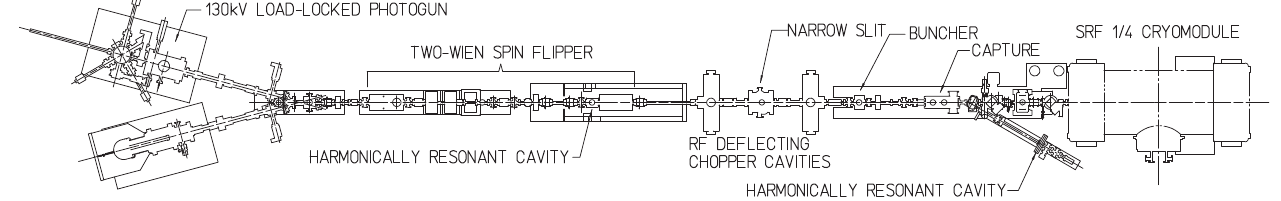
FIG. 2. The CEBAF photoinjector. Note the location of the chopping system, and the two measurement locations of the harmonically resonant cavity bunch-length